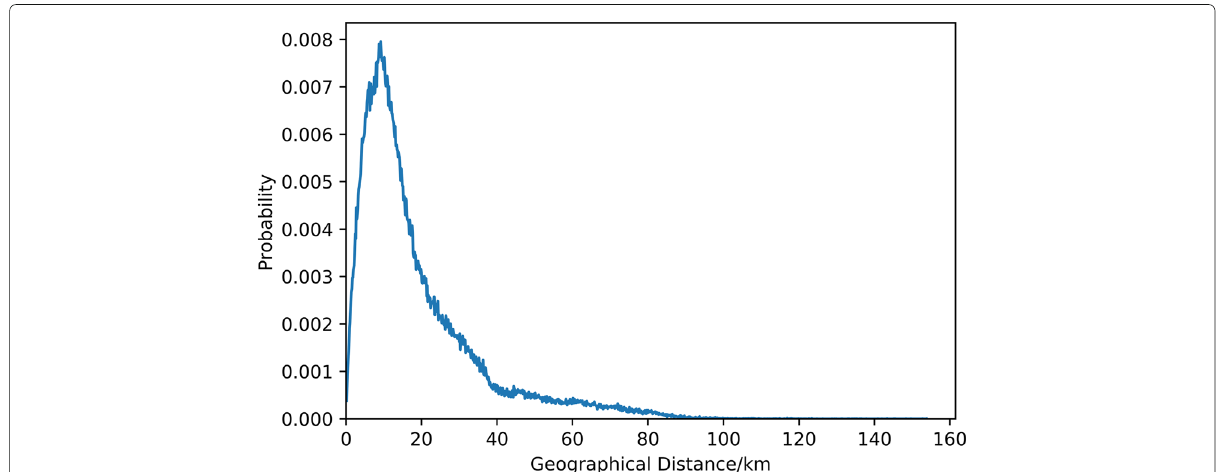
Fig. 7 Conditional probability distribution of geographical distance given RTT and N